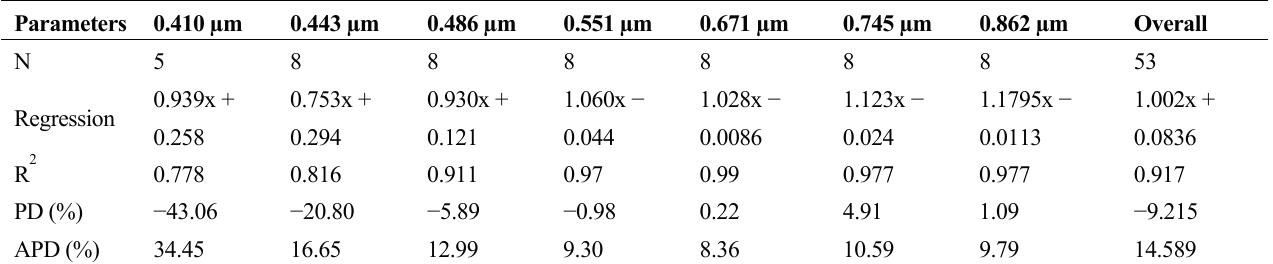
Figure 12. Scatter plots of VIIRS versus MODIS APS derived nLw estimates from 9 March 2013 for the eight locations marked in Figure 9 and with each of the seven ocean color channels plotted separately. Table 3. Statistical results on the comparisons on nLw between MODIS and VIIRS for data collected over Chesapeake Bay areas on 9 March